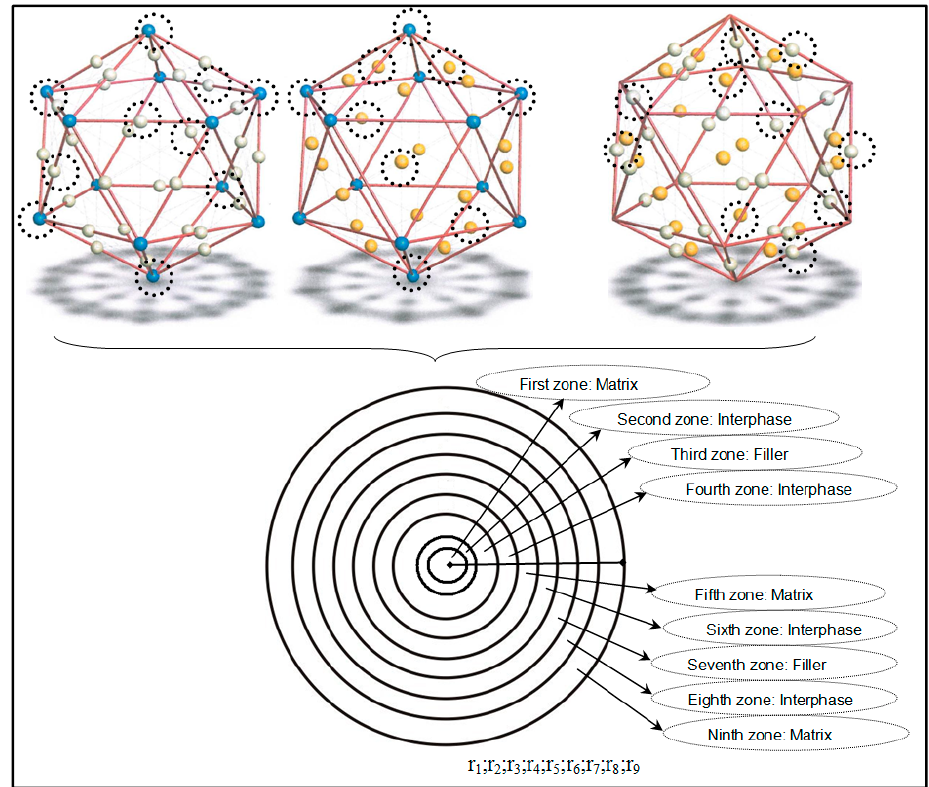
Figure 5. Transformation of the final unit cells into a nine-phase spherical representative volume element (RVE).